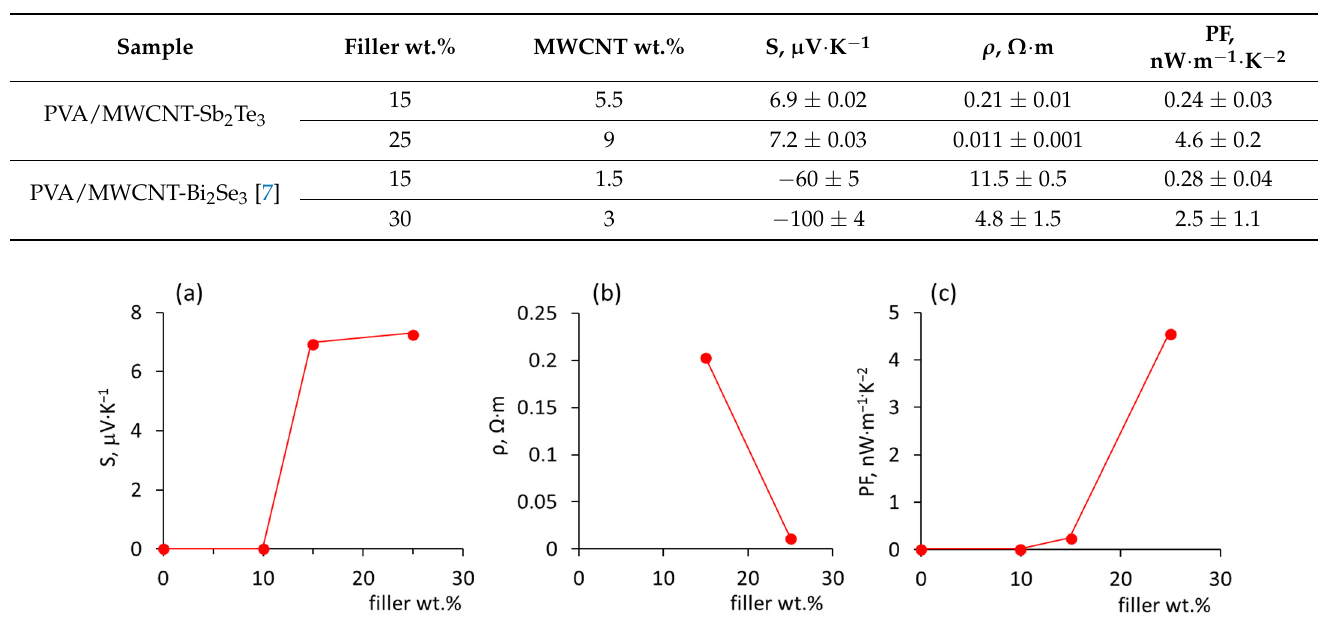
Figure 2. Comparison of the properties of the PVA/MWCNT-Sb 2 Te 3 with10 wt.%, 15 wt.%, and 25 wt.% filler: ( a ) Seebeck coefficient; ( b ) electrical resistivity; ( c ) power factor. Table 1. Comparison of electrical resistivity, Seebeck coefficient and power factor of PVA ‐ based composites with different types of fillers.